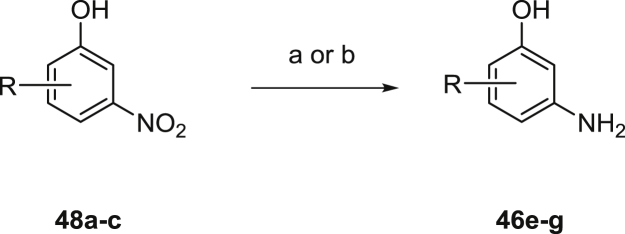
Synthesis of anilinophenols via nitro reduction. aReagents and conditions: (a) Pd/C, H2, EtOH or (b) Fe, AcOH, EtOH.